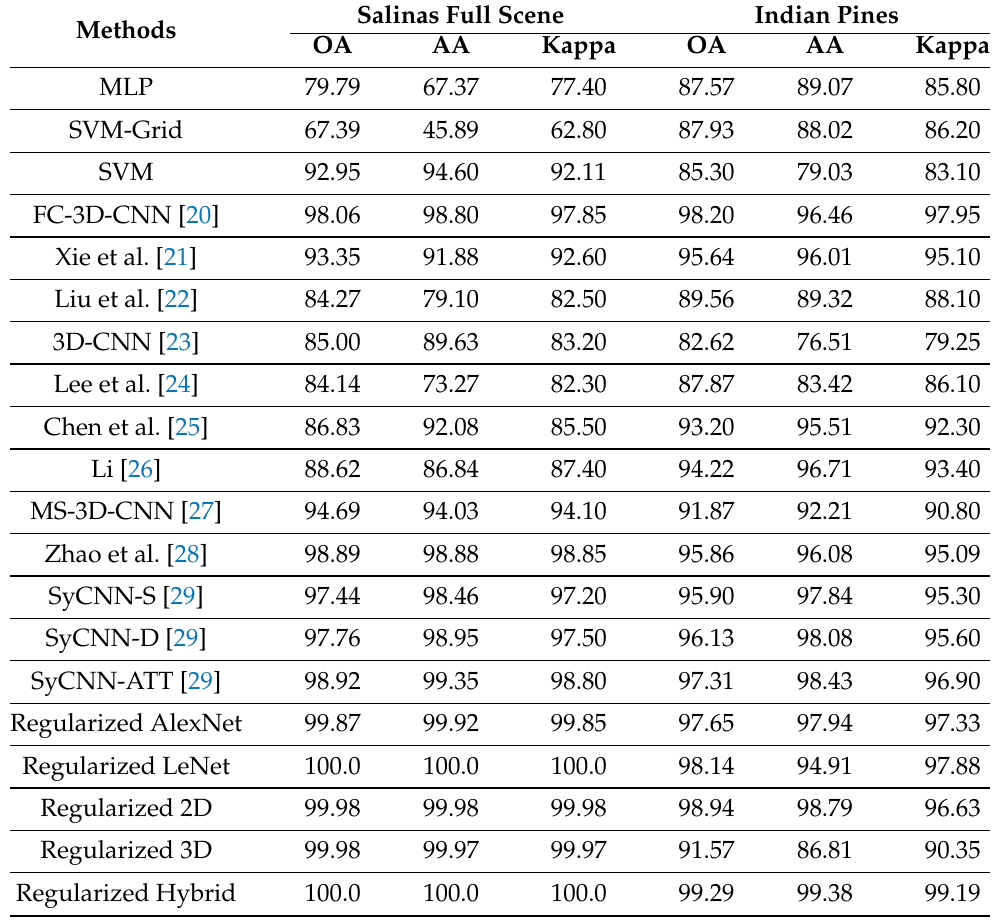
Table 4. Experimental comparison with state-of-the-art